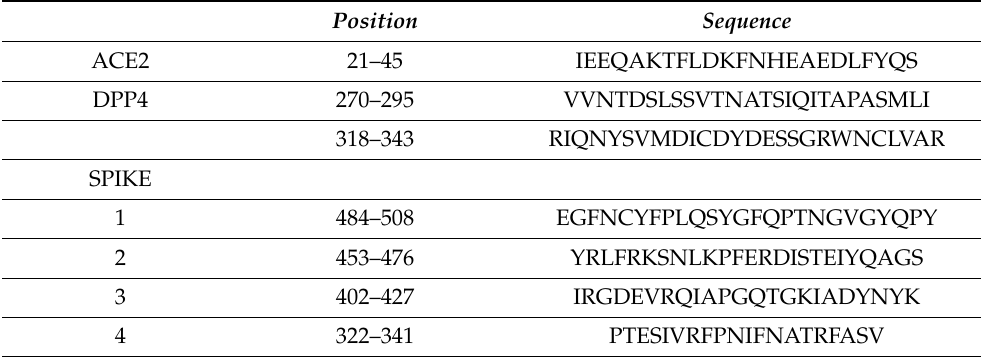
Table 1. Selected peptides sequences